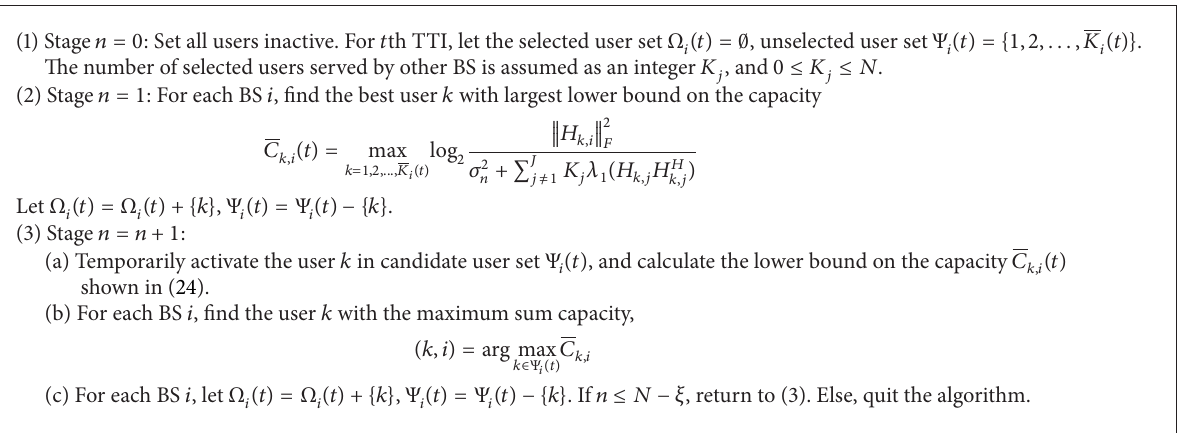
Algorithm 1: Decentralized user selection with interference